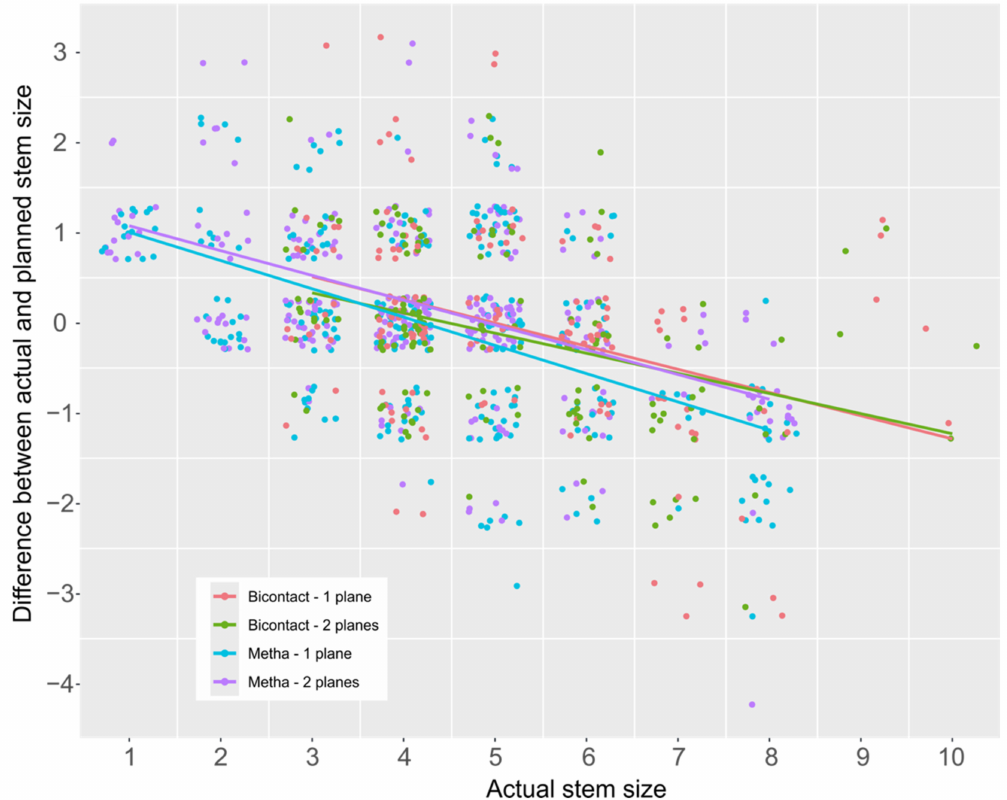
Figure 4. Scatterplots of the difference between actual and planned stem size over the actual stem size. CTHA with one plane planning is displayed in red, two plane planning is displayed in green. STHA with one plane planning is displayed in blue, two plane planning is displayed in purple. Linear regression lines are displayed for all implants and planning methods. For comparability, the implant sizes of the CTHA were substracted by 10.